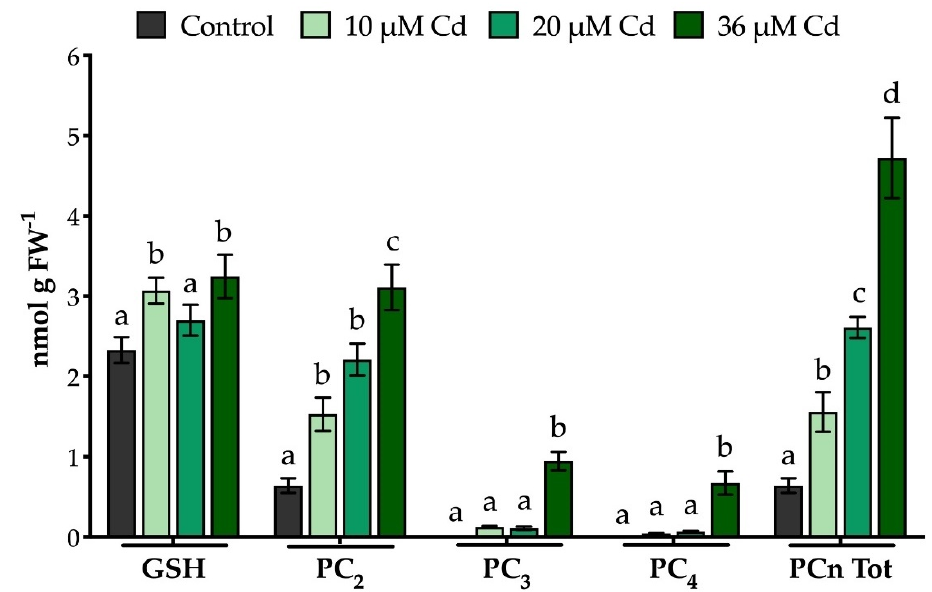
Figure 5. Thiol-peptide content detected in M. polymorpha gametophytes (control and treated plants with 10, 20 and 36 μ M Cd 2+ for 72 h). Values are mean ± SE. Differences between levels of thiol- peptides were detected by one-way analysis of variance (ANOVA), followed by Tukey’s multiple comparison post hoc test. Within each group of thiol-peptides, bars not accompanied by the same letter are significantly different at p < 0.05.